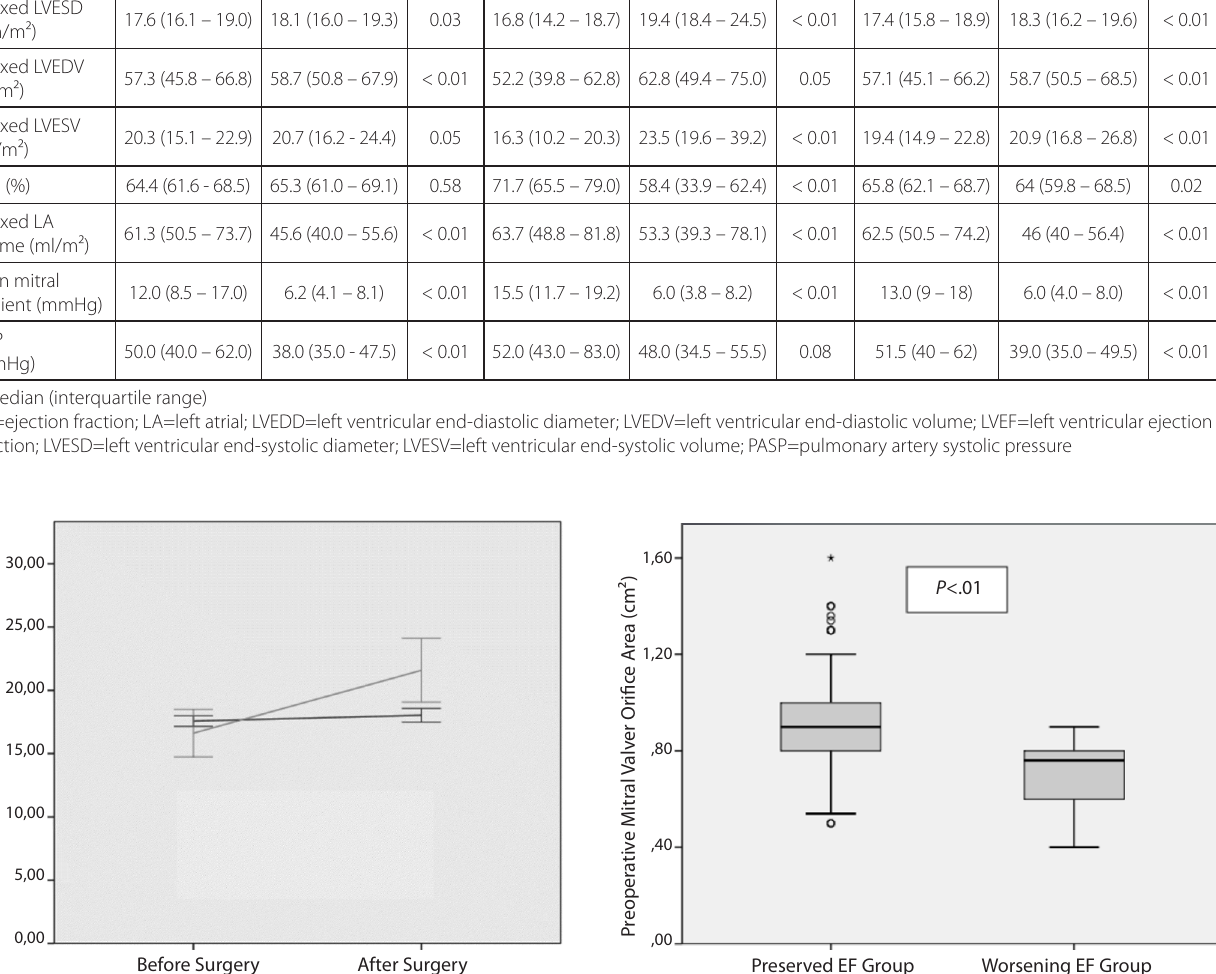
Fig. 2 - Mitral valve orifice area before surgery according to the study group. EF=ejection